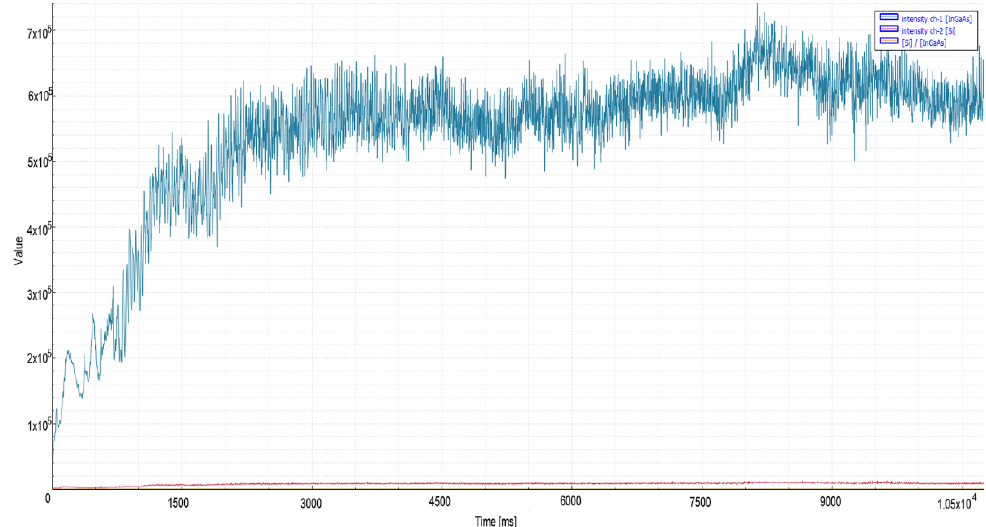
Figure 10. Measurement values recorded during oxygen cutting of 25 mm mild steel material. Table 6. Example piercing and cutting parameter set used in 10 kW